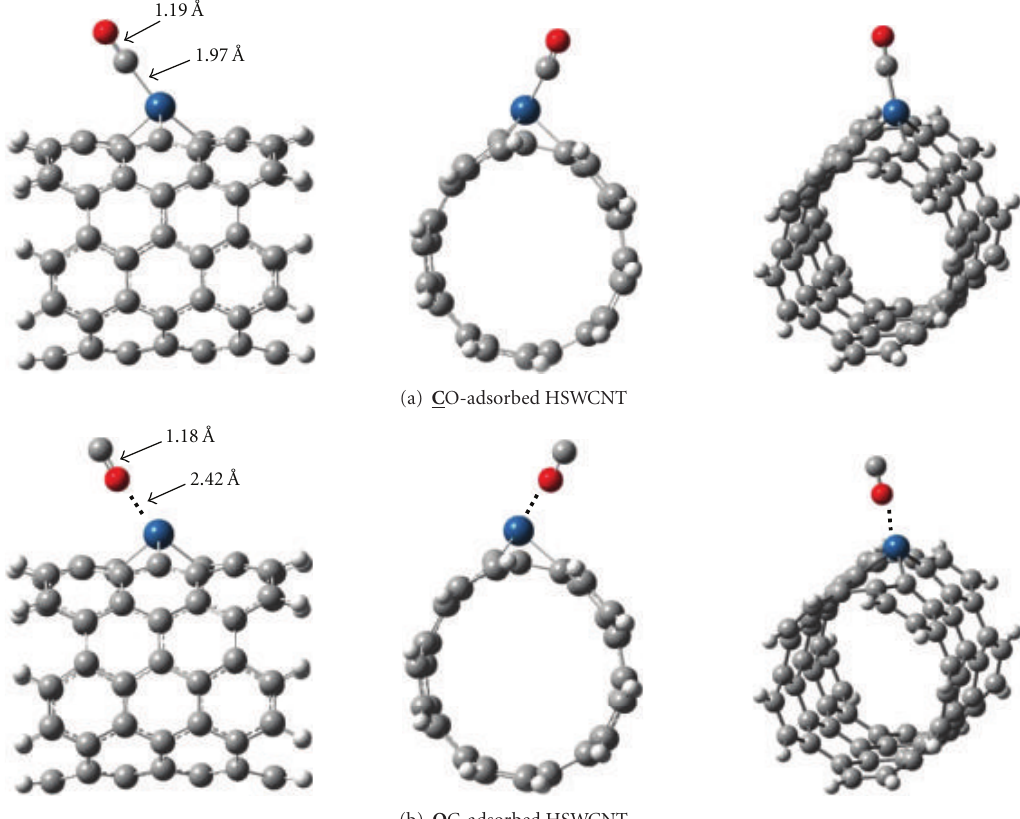
Figure 19: Optimized geometries for the adsorption of CO onto a Pt-doped SWCNT. From left to right, these are views perpendicular to the nanotube axis, along the axis, and a 3D perspective [114]. Legend: dark grey = carbon, light grey = hydrogen, red = oxygen, blue =